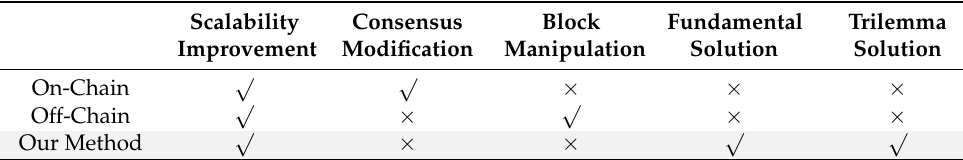
Table 2. Comparison between Our Proposed Method and the